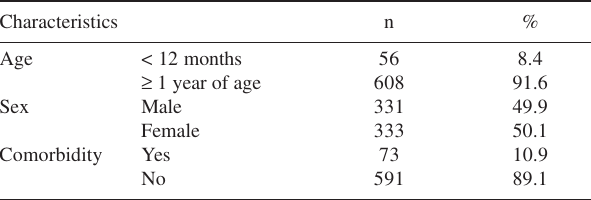
Table 2 - Characteristics of children attending day care centers with positive antecedent to varicella